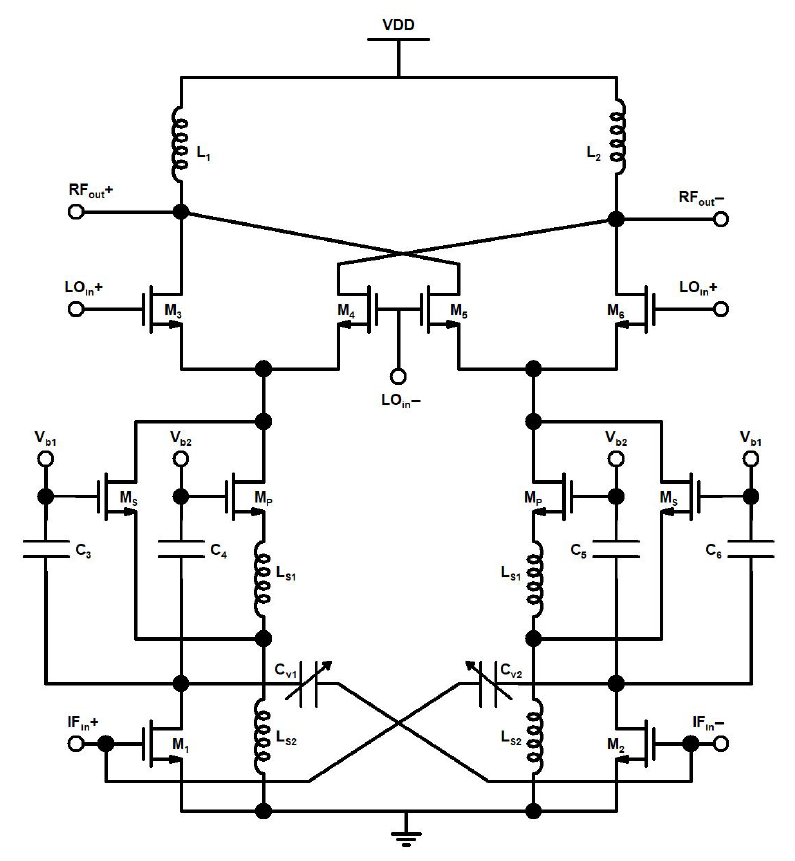
Figure 4. Proposed up-conversion mixer.